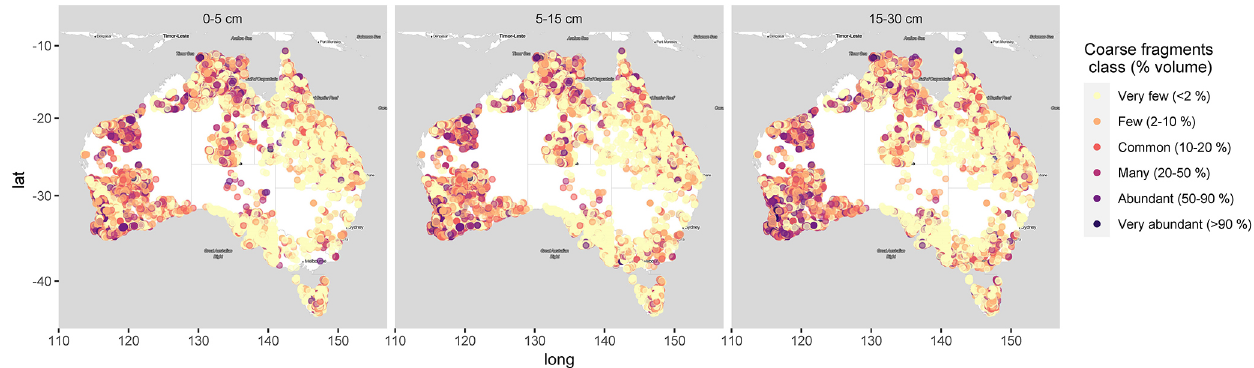
Figure 3. Calibration data on coarse-fragment (%vol) classes for the 0–5, 5–15, and 15–30cm depth intervals.